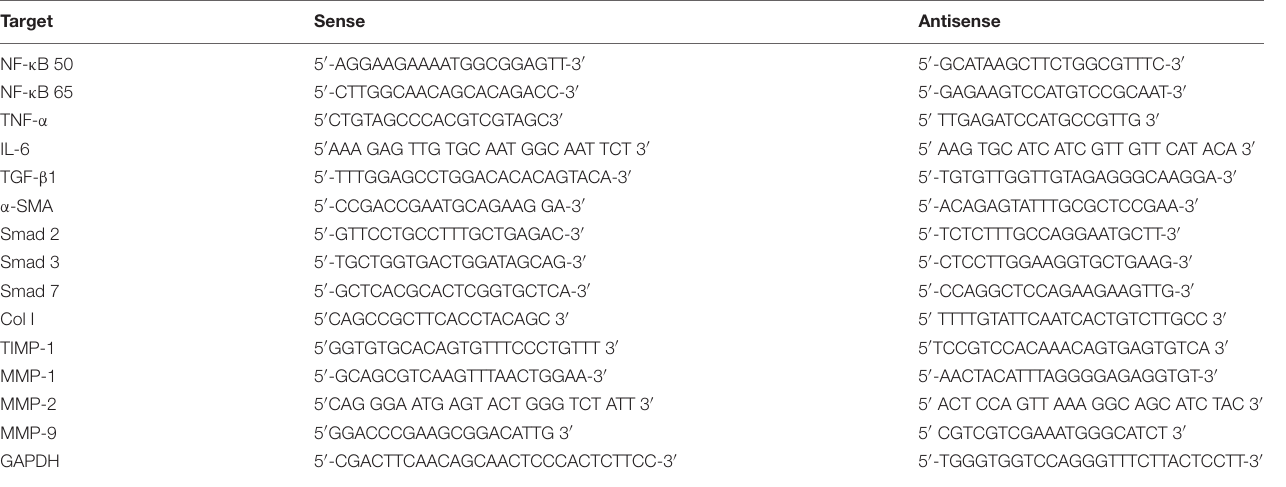
TABLE 1 | Primer sequences for